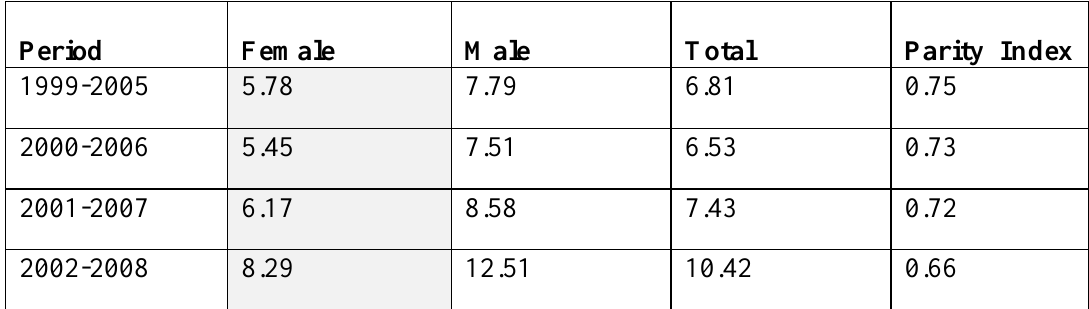
Table 3.2: Secondary School Completion Rates, Form 1 to Form 6, by sex and parity index, Zimbabwe 2004-2008